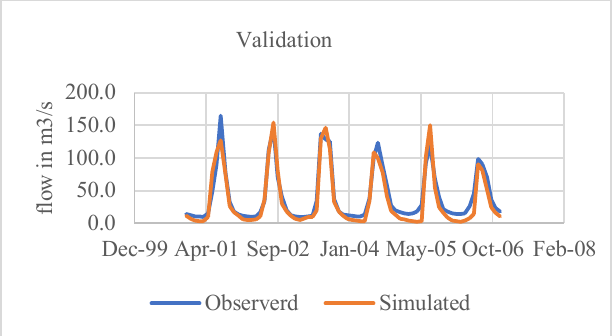
Figure 5. Observed & Simulated monthly flow hydrograph for